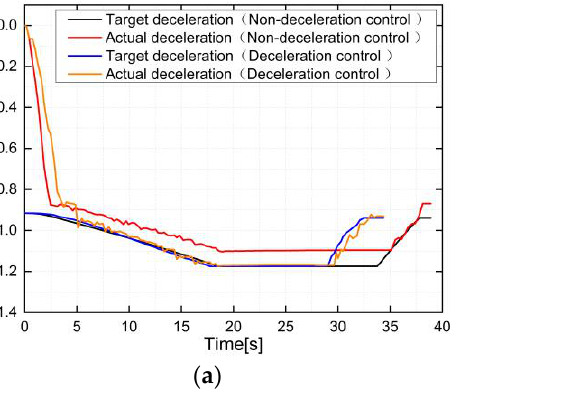
Figure 13. Test results with uncertain braking force feedback errors: ( a ) brake cylinder pressure sensor error is 5% under a pure pneumatic full-service braking condition; ( b ) electric braking force feedback error is 10% under an electro-pneumatic full-service braking condition.